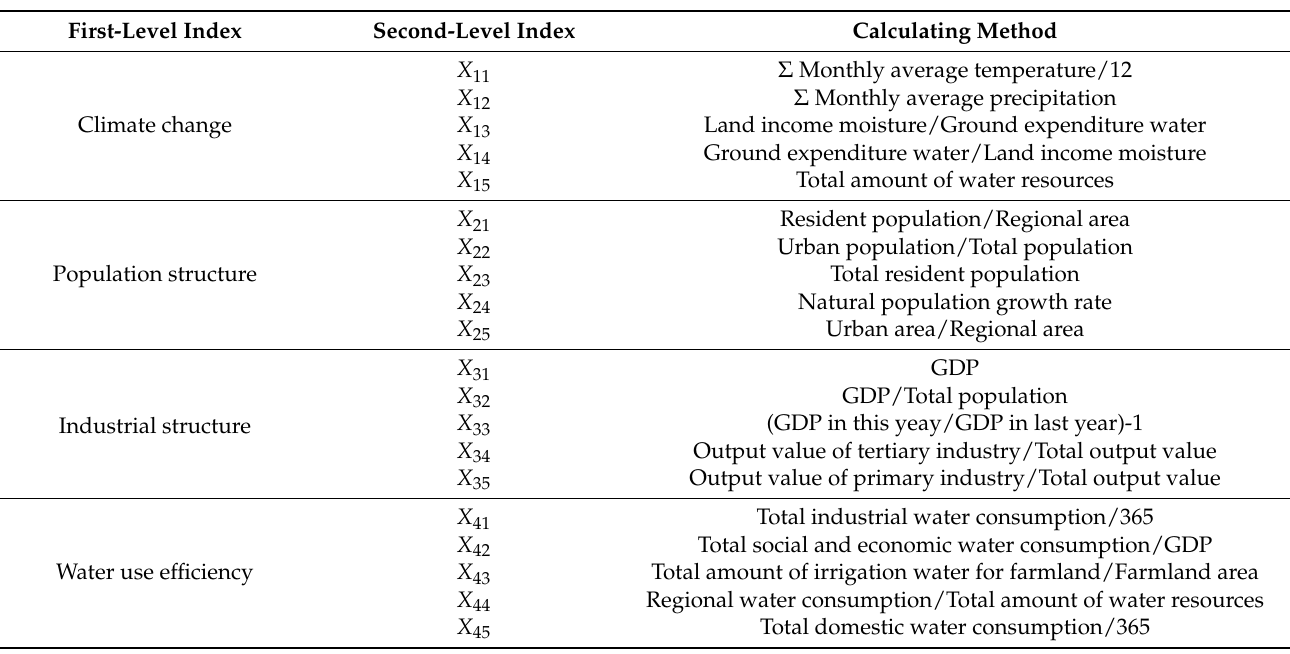
Table A2. Calculation method of each secondary index in Table 3.